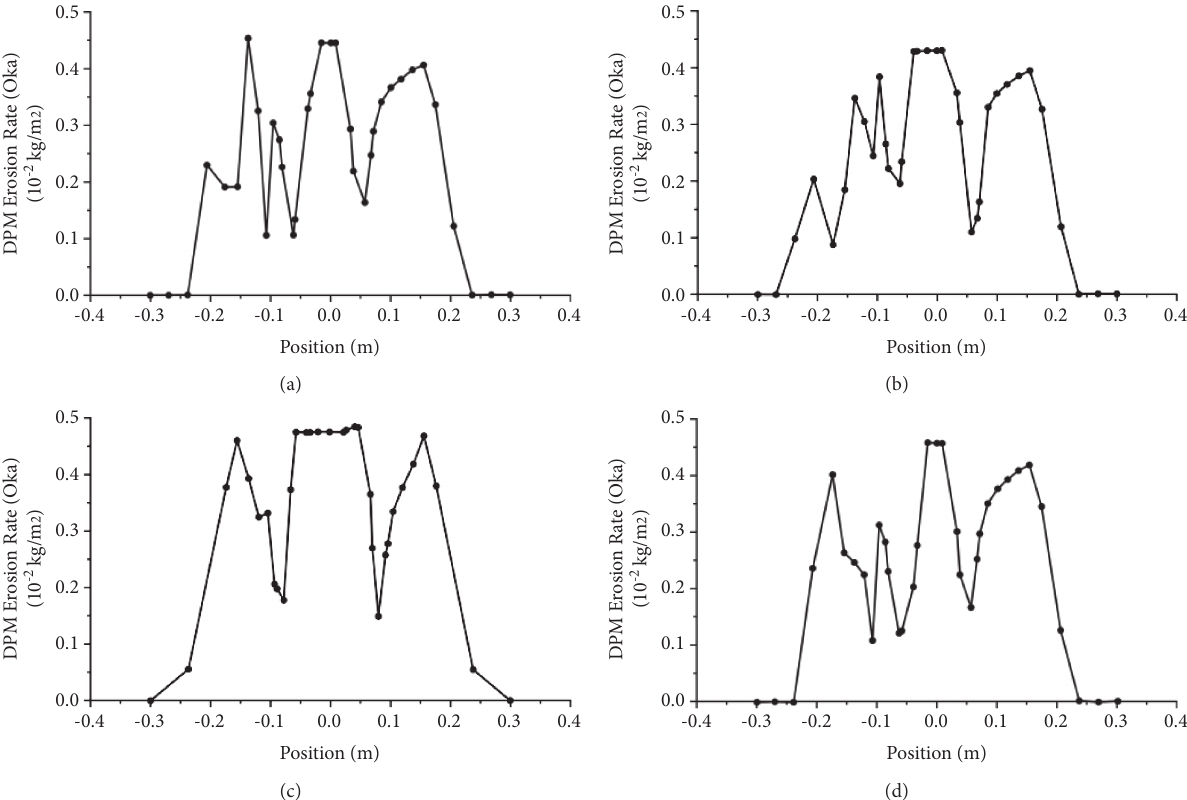
Figure 12: The erosion curve of the blade surface with different spraying distances. (a) The erosion curve of the blade surface with the spraying distance of 300mm. (b) The erosion curve of the blade surface with the spraying distance of 400mm. (c) The erosion curve of the blade surface with the spraying distance of 500mm. (d) The erosion curve of the blade surface with the spraying distance of 600mm.